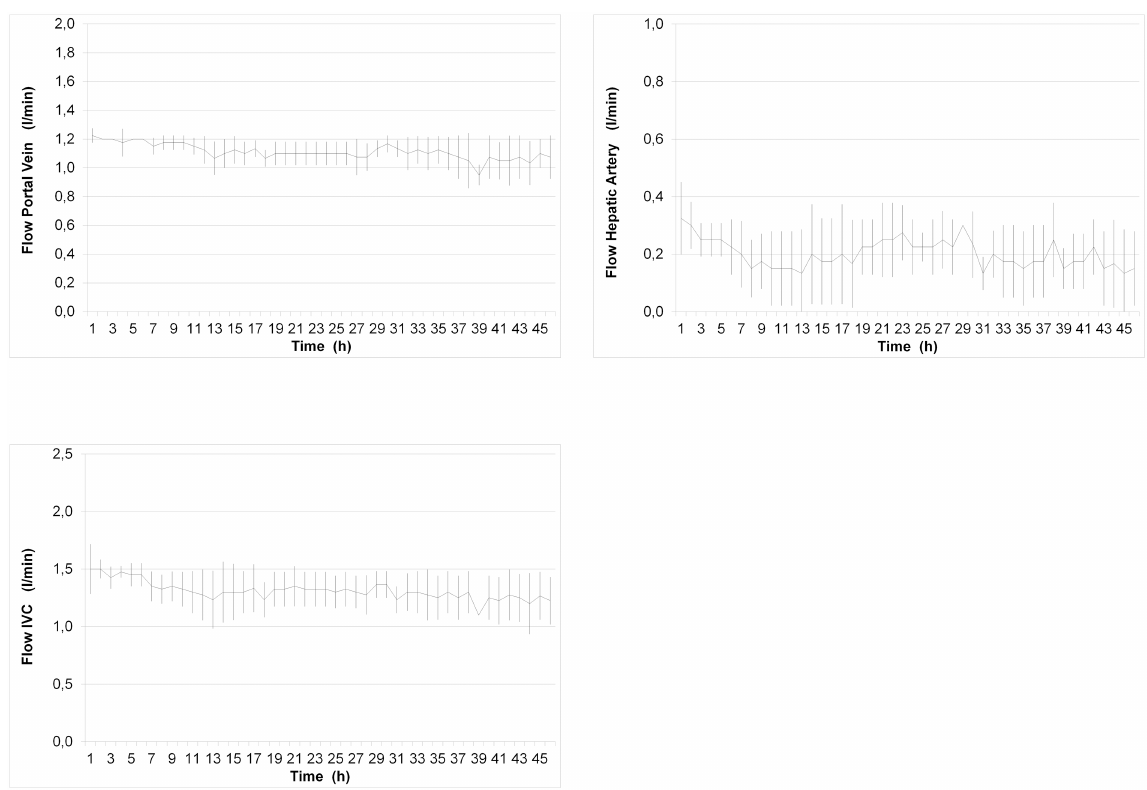
Fig 4. Perfusion flows during 46 hours of normothermic perfusion. (A) portal flow ± SD, (B) hepaticartery flow ± SD, (C) IVC flow ± SD. Perfusate flows were measuredin-lineusing ultrasonic flow probes.